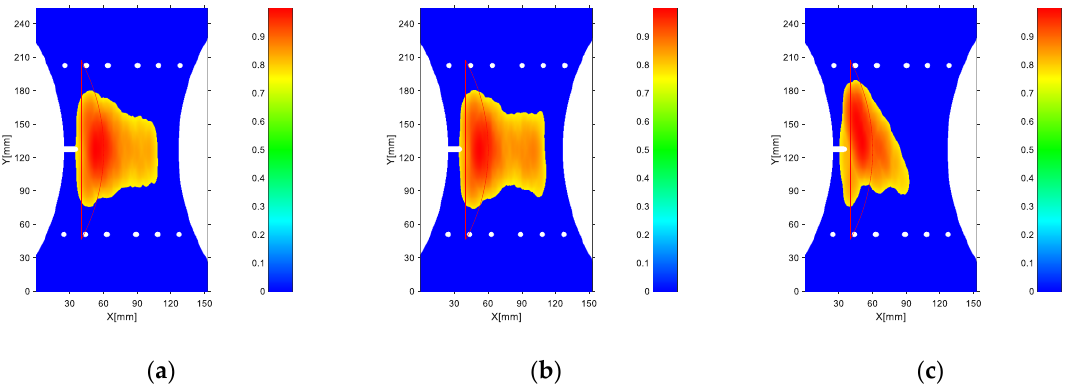
Figure 23. Thresholded imaging with different damage factors at a signal-to-noise ratio of 3 dB: ( a ) energy damage factor; ( b ) cross-correlation damage factor; ( c ) sparse representation damage factor.